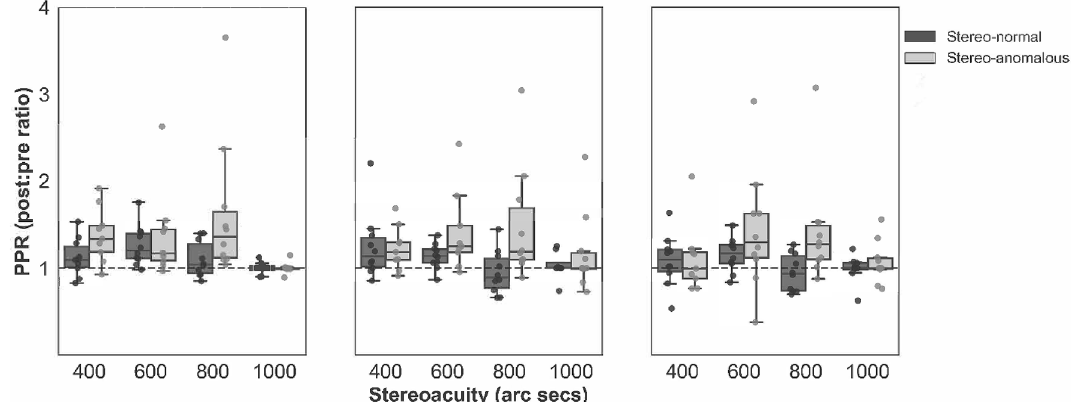
Figure 7. Box plot comparing d’ PPR values between stereo-normal (dark grey) and stereo-anomalous (light grey) groups across stereoacuity demand (400 ″ , 600 ″ , 800 ″ , and 1000 ″ ) and Conditions (1, 2, and 3). Condition 1 (left panel), Condition 2 (middle panel), and Condition 3 (right panel). Each symbol represents individual data.